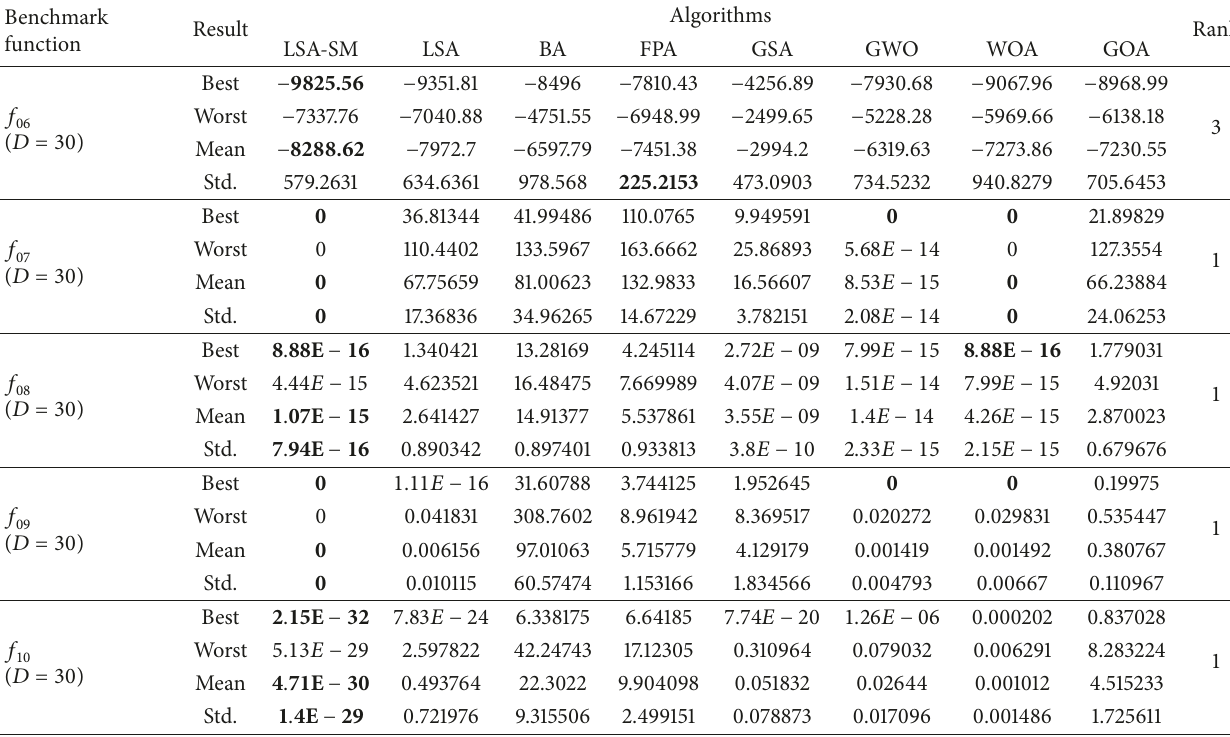
Table 5: Results of multimodal benchmark